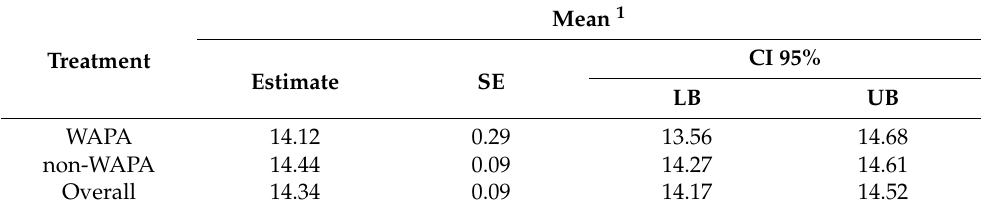
Table 2. Means calculation for clinical WAPA and non-WAPA groups.